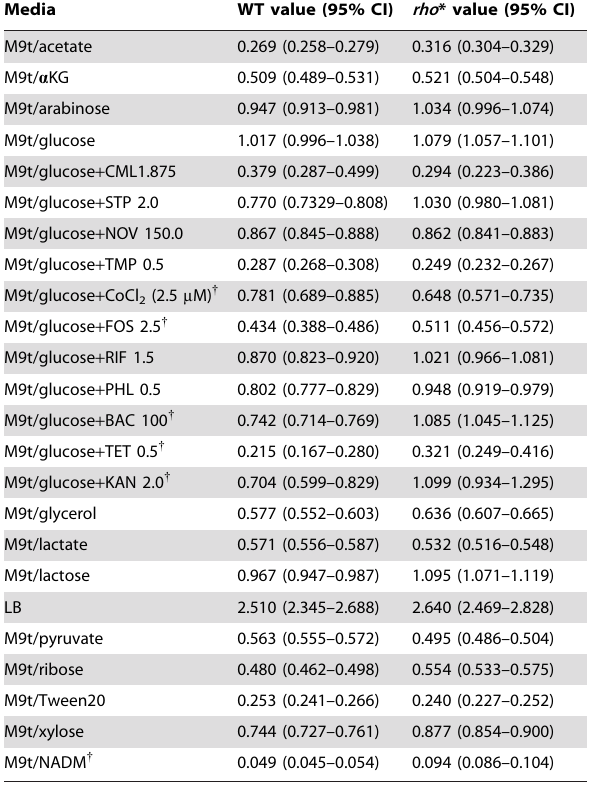
Table 1. Conditions showing significant differences in growth rate between WT and rho * cells (relative to growth in